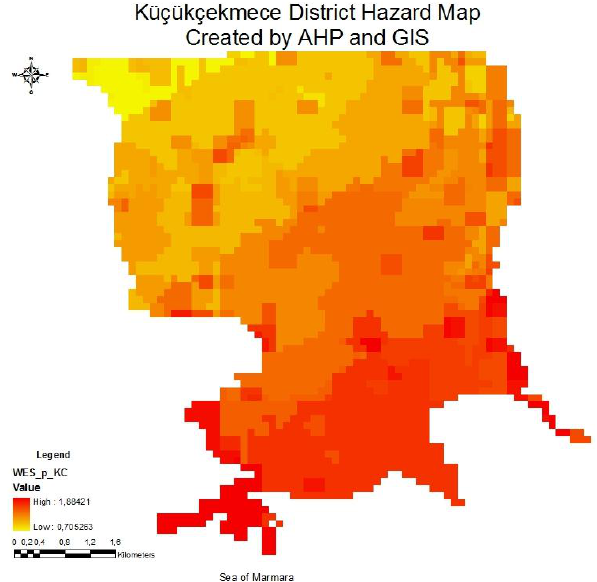
Figure 4 Hazard map created by AHP and GIS 2 Fig. 4. Hazard map created by AHP and GIS.